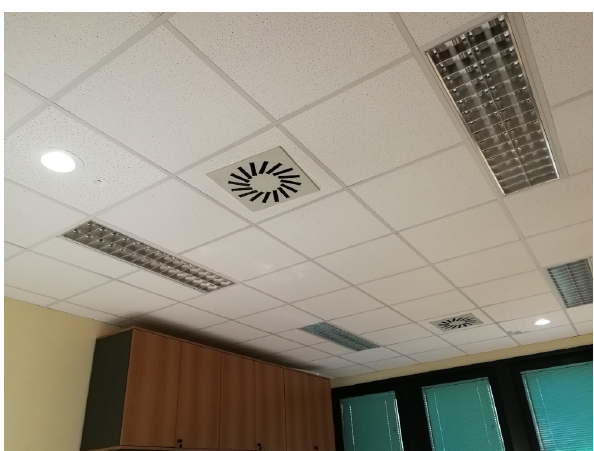
Figure 5. Ceiling: LED lamps, IR sensors, and neon